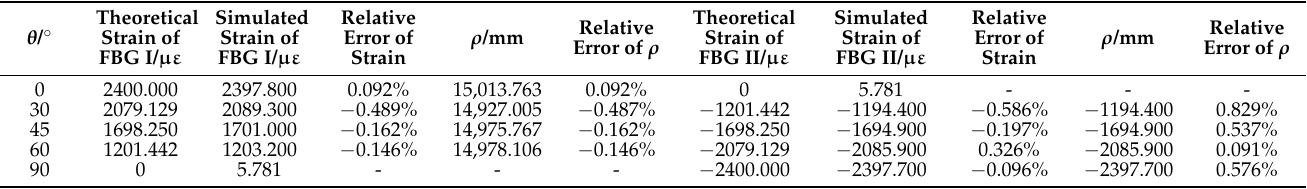
Table 1. Comparison between simulated and theoretical values of FBG under different rotation angle errors.